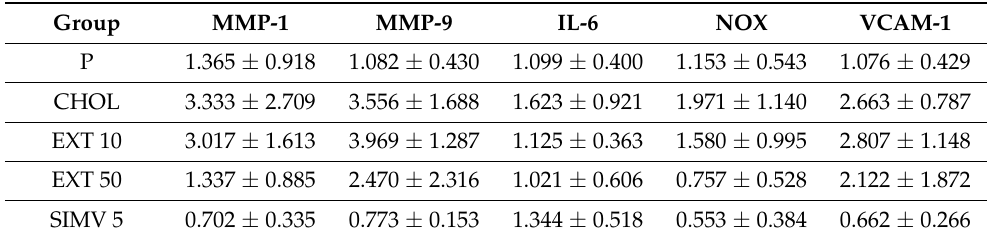
Table 1. mRNA expression of MMP-1, MMP-9, IL-6, NOX, and VCAM-1 in the aorta. Values are presented as mean ± SD.